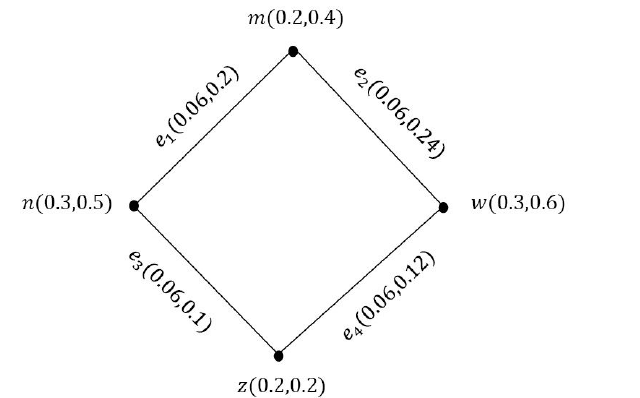
Figure 9. Vague graph ζ with effective